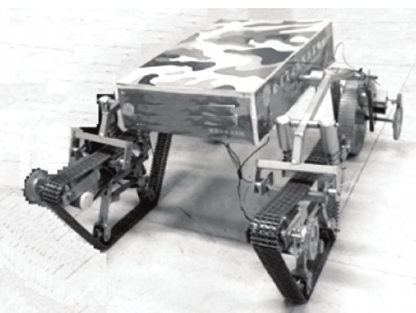
Figure 17: Pareto frontier.